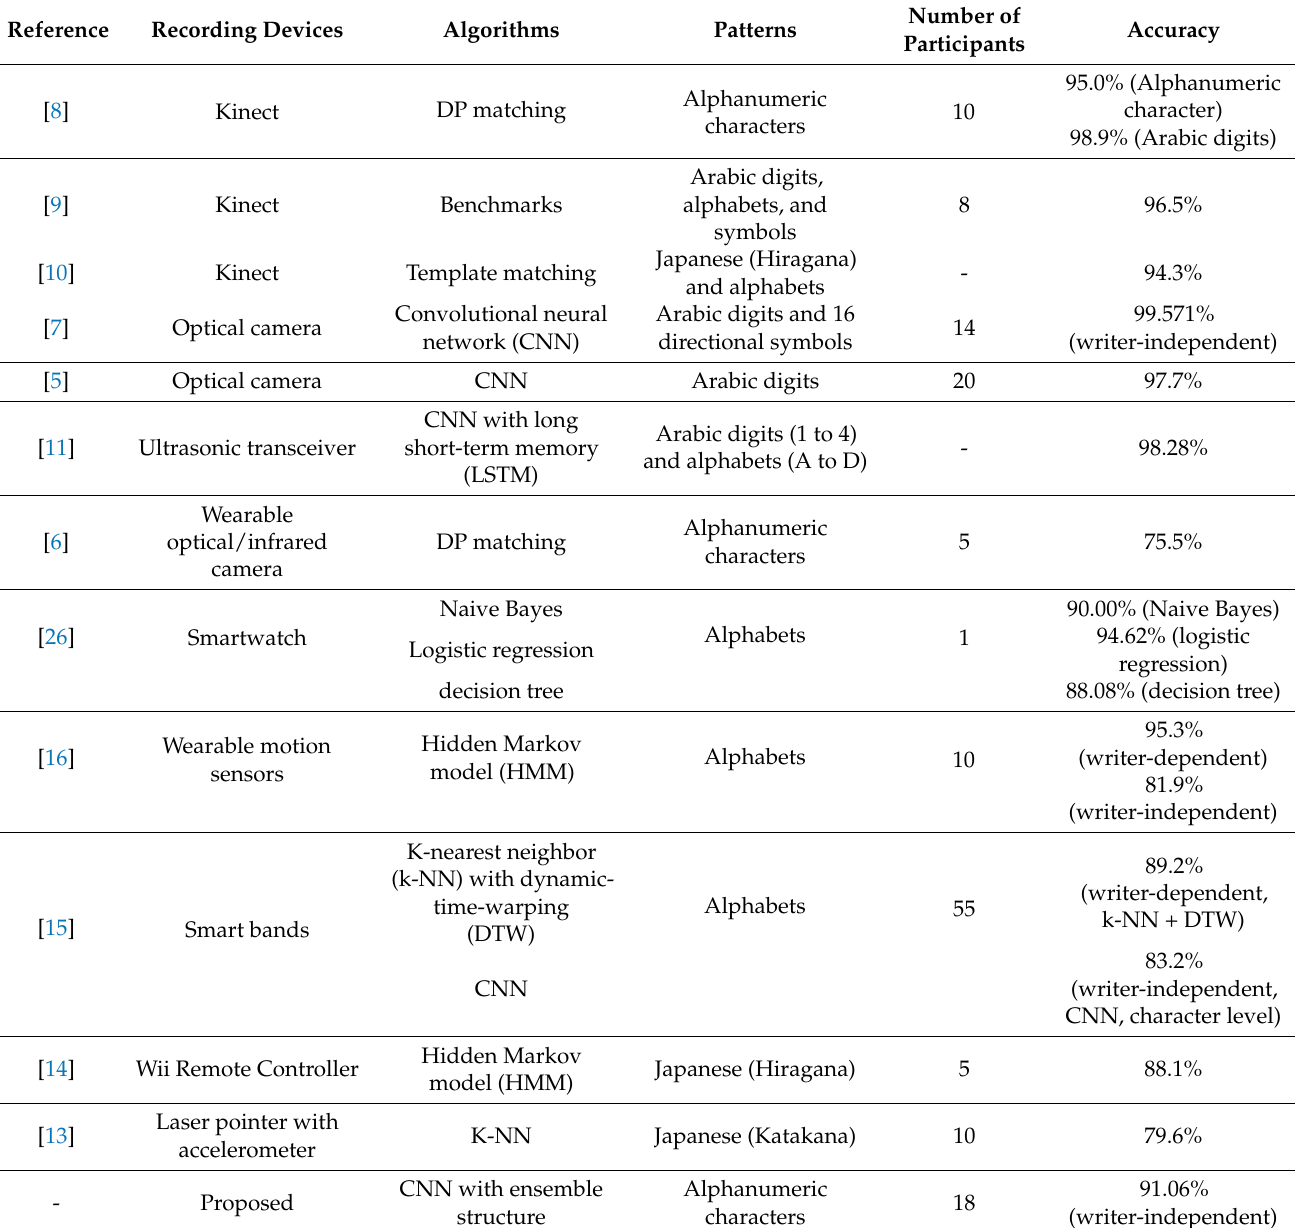
Table 1. Comparison of the studies on air-writing hand gesture